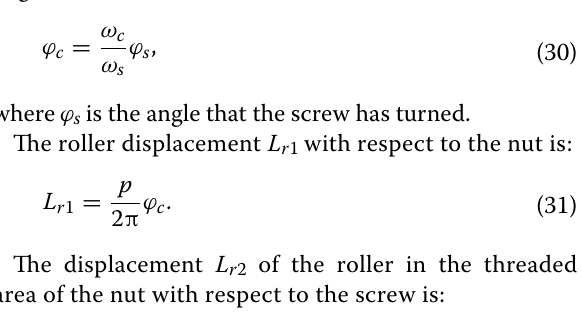
Figure 8 RPRSM motion